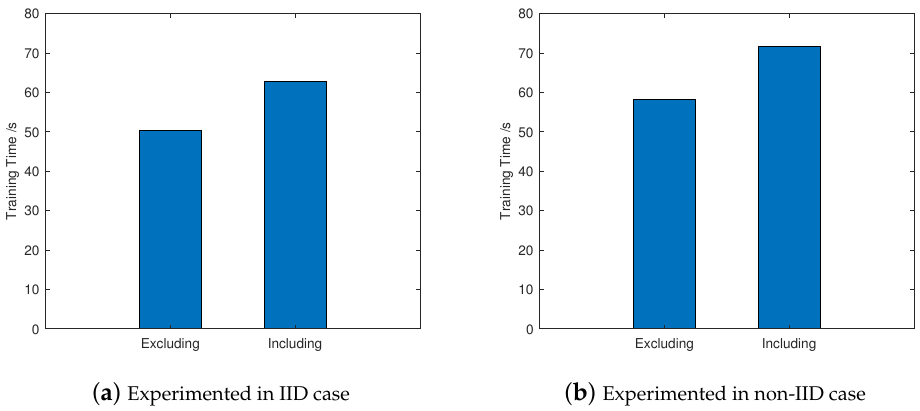
Figure 13. Comparisons of training time including and excluding blockchain of FL for MNIST data set in IID and non-IID cases.